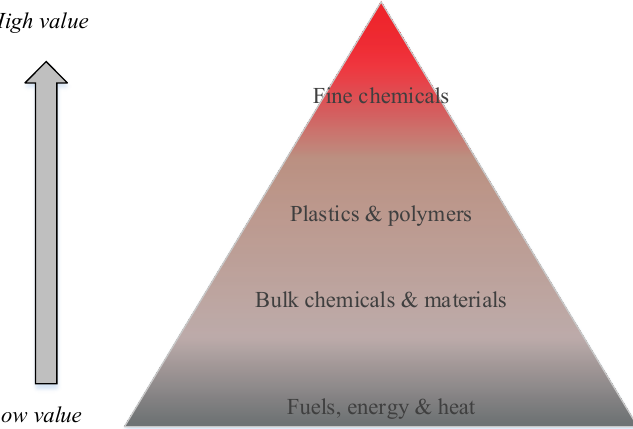
Fig. 3. Products value pyramid (Authors’ illustration adapted from